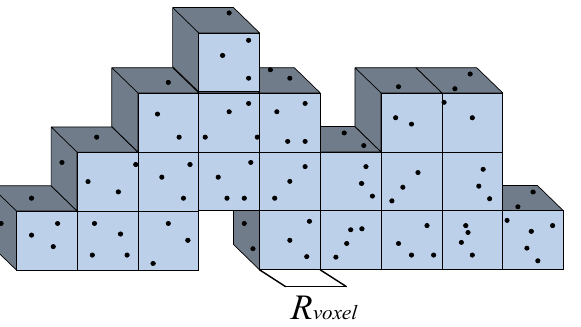
Figure 3. Representation of voxels generated by octree. The different cubes represent voxels, the dots represent the original points. The leaf size ( R voxel ) was set at 1 mm in the experiments. The points include not only objects but also planes and other noisy points that will go against the subsequent instance segmentation. The random sample consensus (RANSAC) algorithm was utilized to remove the plane. The RANSAC algorithm randomly sampled three points as the minimum point set to generate a hypothetical plane in every iteration. Then, the distance between the remaining points and the plane generated by these three points was calculated by the following Formula (2):